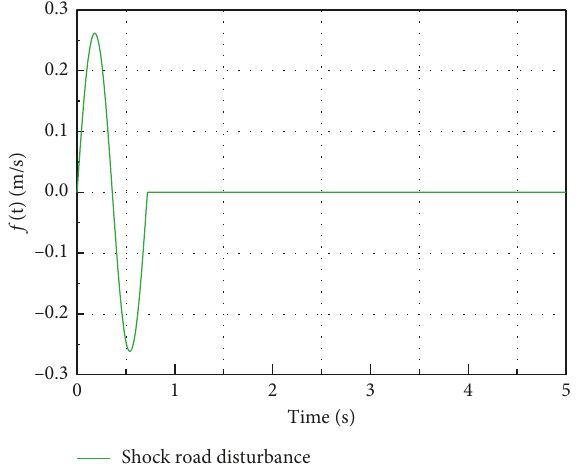
Figure 4: Shock road disturbance.